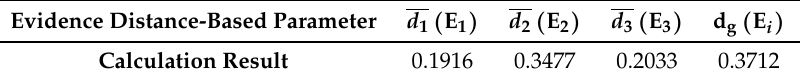
Table 4. The average distance and global distance of E i ( i = 1,2,3).